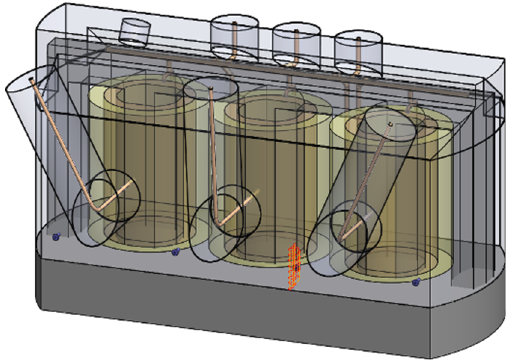
Figure 23. The visualization of the localized artificial signal source position in the third inlet.